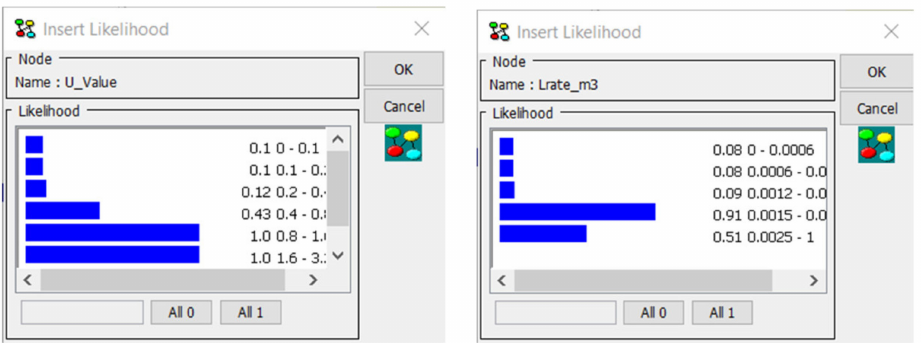
Figure 17. The input boxes of the likelihood distributions of the U_Value and Lrate_m3